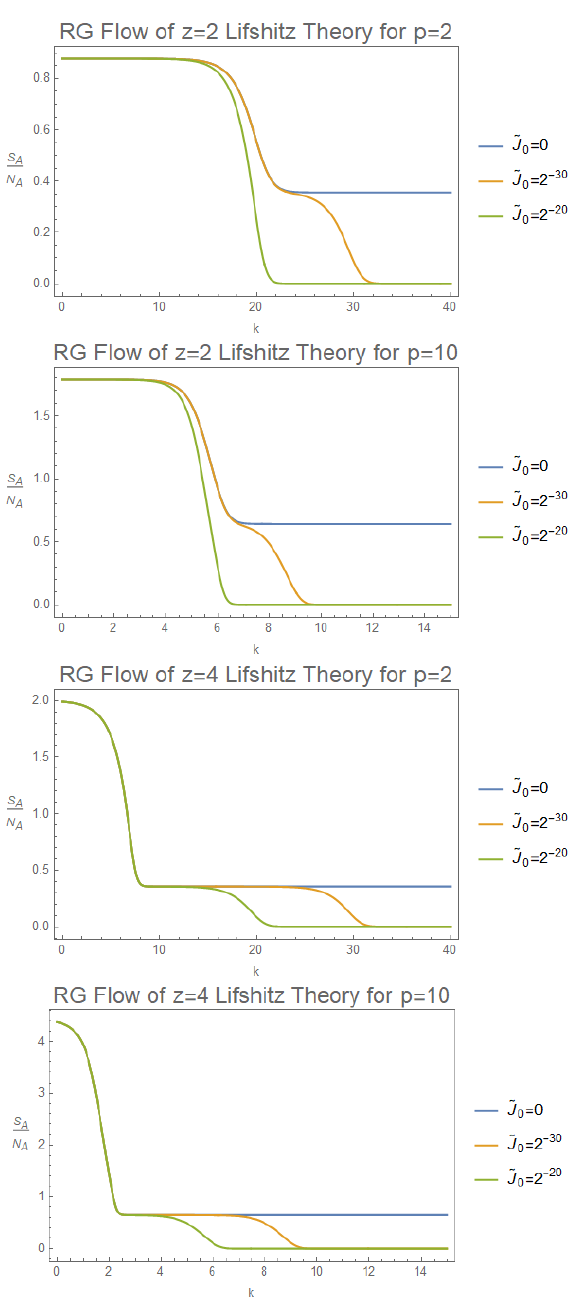
Figure 7: Plots of the RG flow of the vacuum EE density for Lifshitz theories in the continuum limit N → ∞ with z = 2,4 and p = 2,10. The first row is for z = 2, while the second row is for z = 4. = 0,2 − 30 , and 2 − 20 while fixing the ratio ˜ J We examine the cases when ˜ J 0 case we fix the ratio by taking the appropriate limit). The UV regime corresponds to small k , and as k increases, we flow into the IR